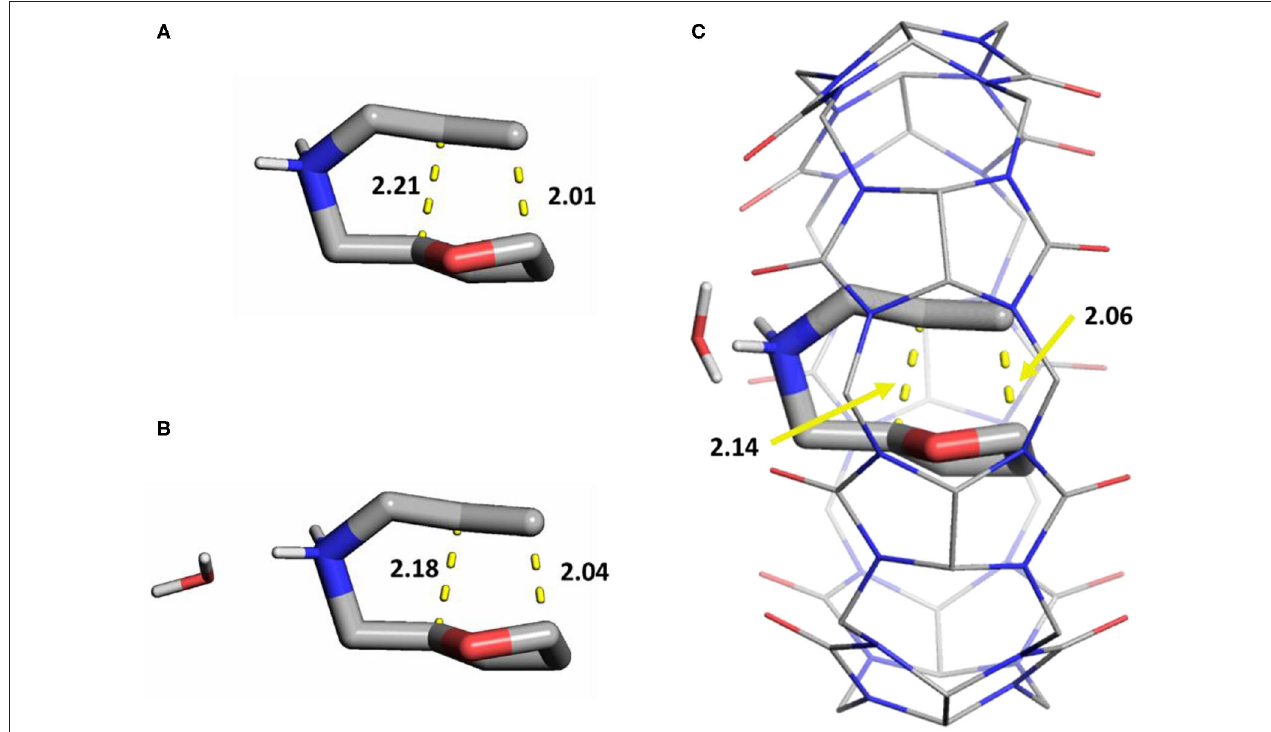
FIGURE 3 | Transition state structures of the cycloaddition in different models for the reaction with 1a (licorice): (A) only implicit water, (B) one explicit water molecule, (C) one explicit water and 1a in complex with CB[7] (lines). Distances of the forming sigma bonds (yellow dashes) are shown in Å. Non-polar hydrogens are hidden for